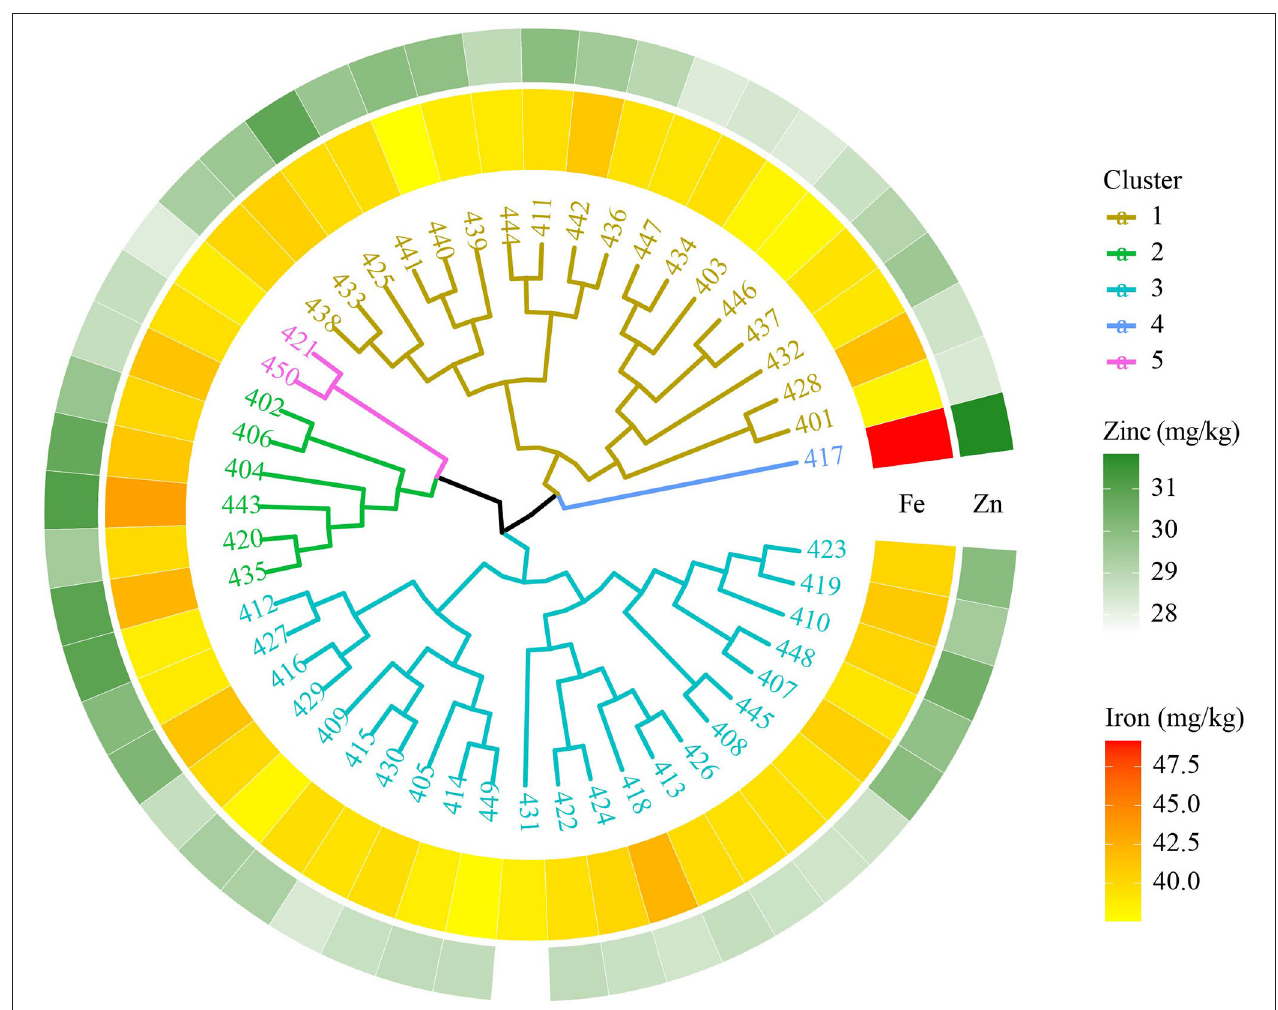
FIGURE 3 | Clustering of biofortified bread wheat genotypes from the 8th HPYT based on BLUP